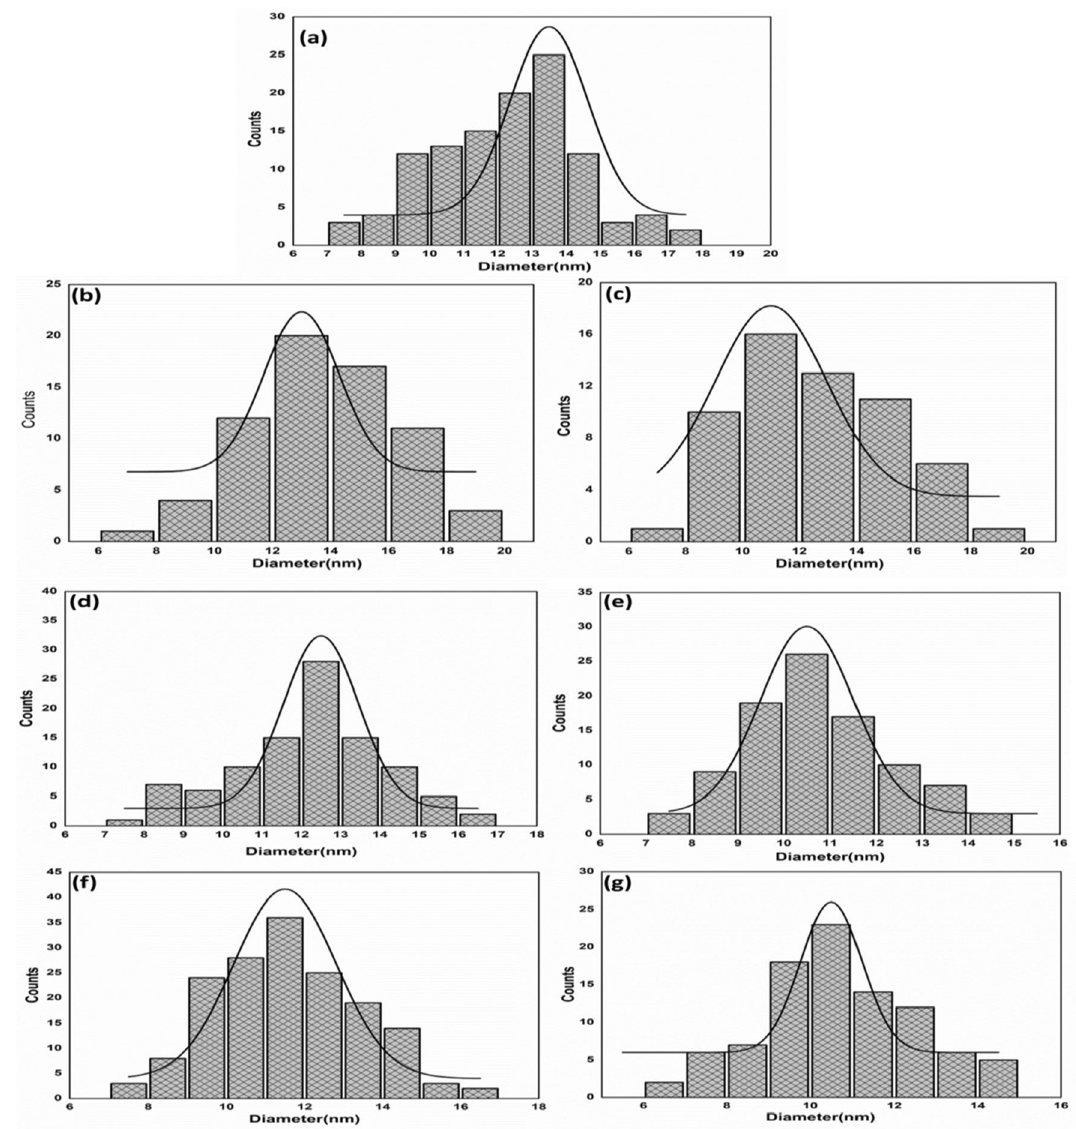
Figure 6. Particle size distribution curves of ( a ) MgO and MgO nanoparticles doped with 3%, 7% of ( b,c ) Ni ( d,e ) Co, and ( f,g ) In the main, the different factors such as band gap, lattice strain, impurity centers, grain size, surface roughness, and oxygen deficiency are related to the absorbance spectrum of the materials. From Fig. 7a–c, the absorption edge of transition metal (Ni, Co, and Fe)-doped MgO nanoparticles shifted toward a lower wavelength than the absorption edge of MgO metal oxide. Among them, the absorption spectrum of transition metal Fe-doped MgO nanoparticles shifted toward a lower wavelength than the absorption spectrum of transition metal Ni and Co- doped MgO nanoparticles. Thus, the blue shift in the absorption spectrum of all samples appeared with increas- ing the doping concentrations of the transition metal Ni, Co, and Fe, as observed in Fig. 7. Thus, the blue shift of the absorption spectrum of the prepared samples was conceivable. In contrast, the transition metal ions of (Ni 2+ , Co 2+ , and Fe 2+ ) were incorporated totally into the Mg 2+ sites of the MgO host lattice 51 . The energy band gap of the samples is estimated by Tauc’s plot Fig. 8a–c using the following Tauc’s Eq. (2) 52,53 .